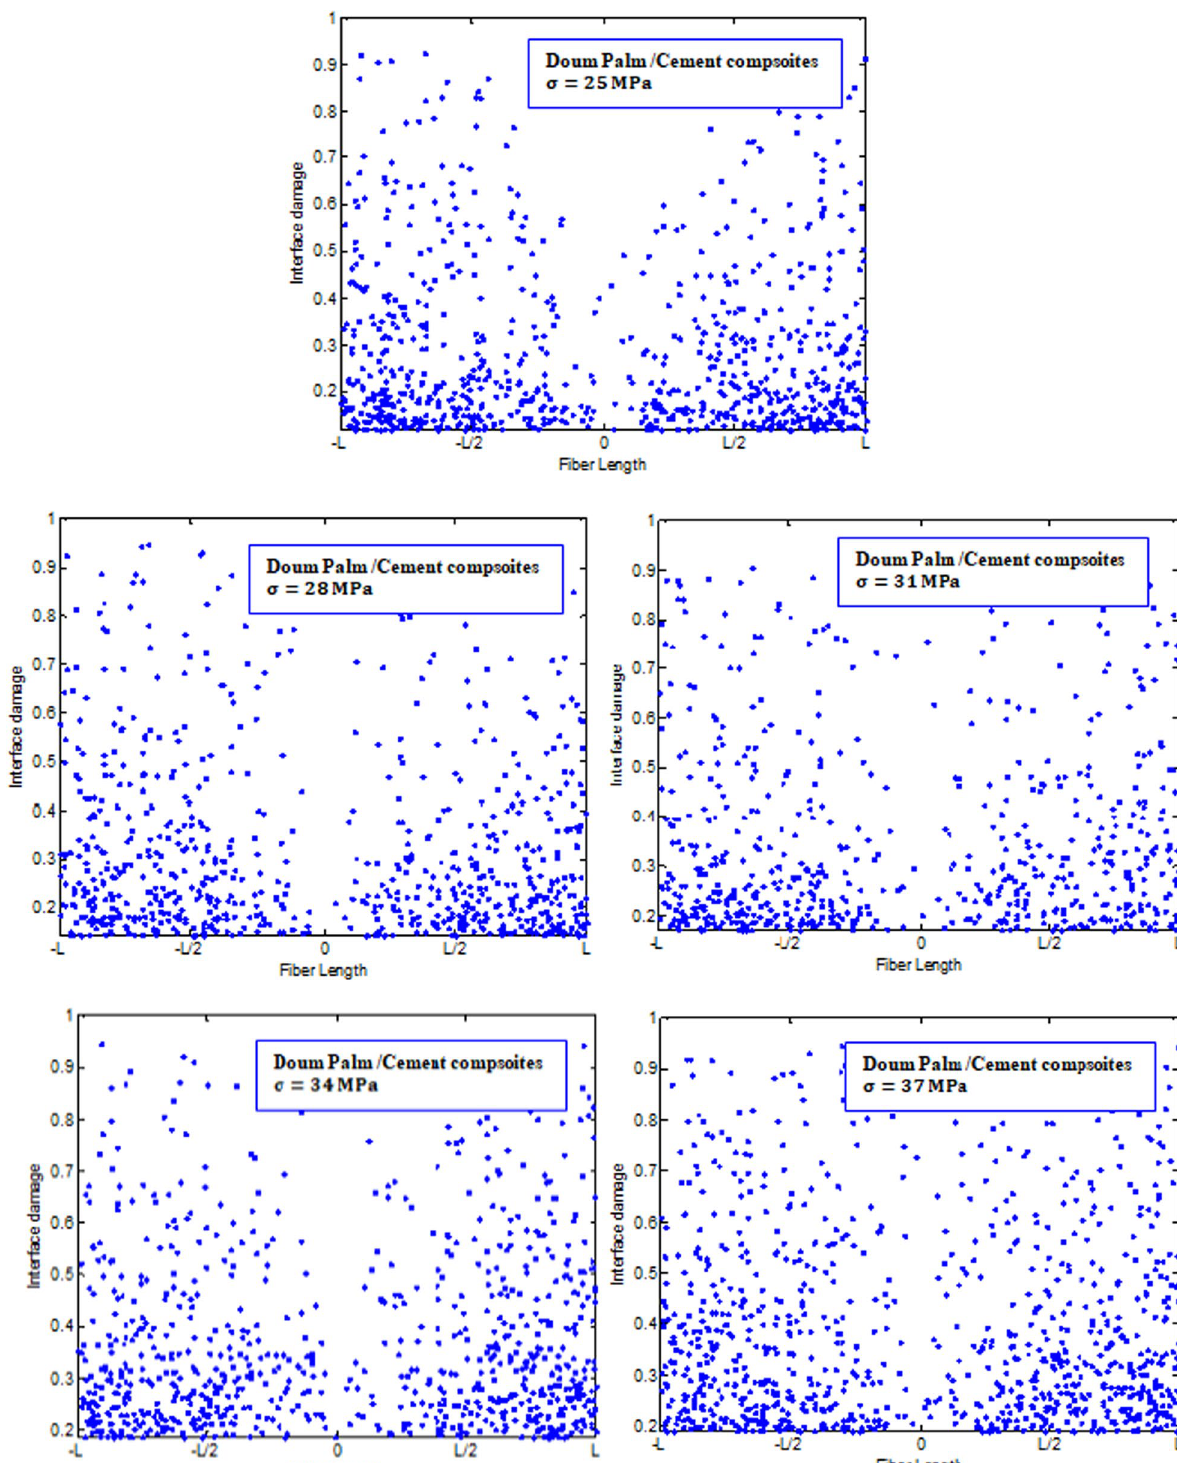
Fig. 6 Fiber-mortar interface damage of Doum Palm/Cement